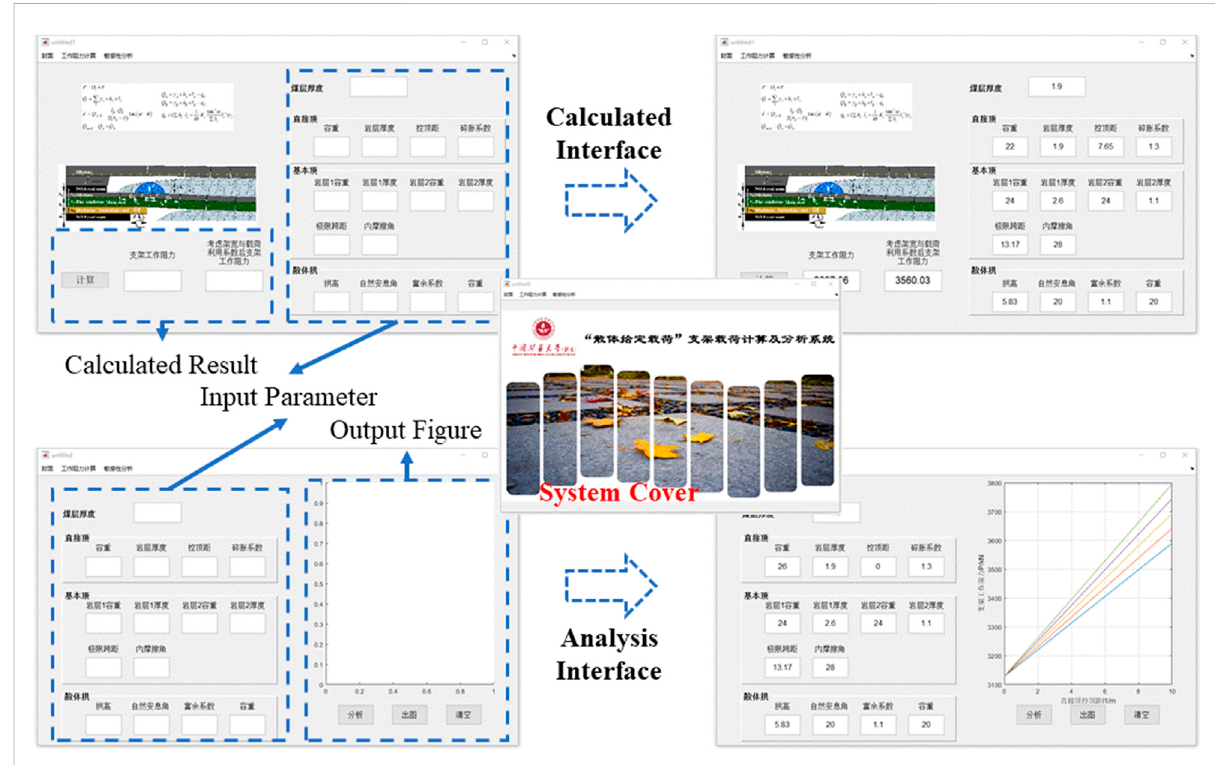
FIGURE 8 Calculation and analysis scheme of the shield support capacity under a given load of the loose